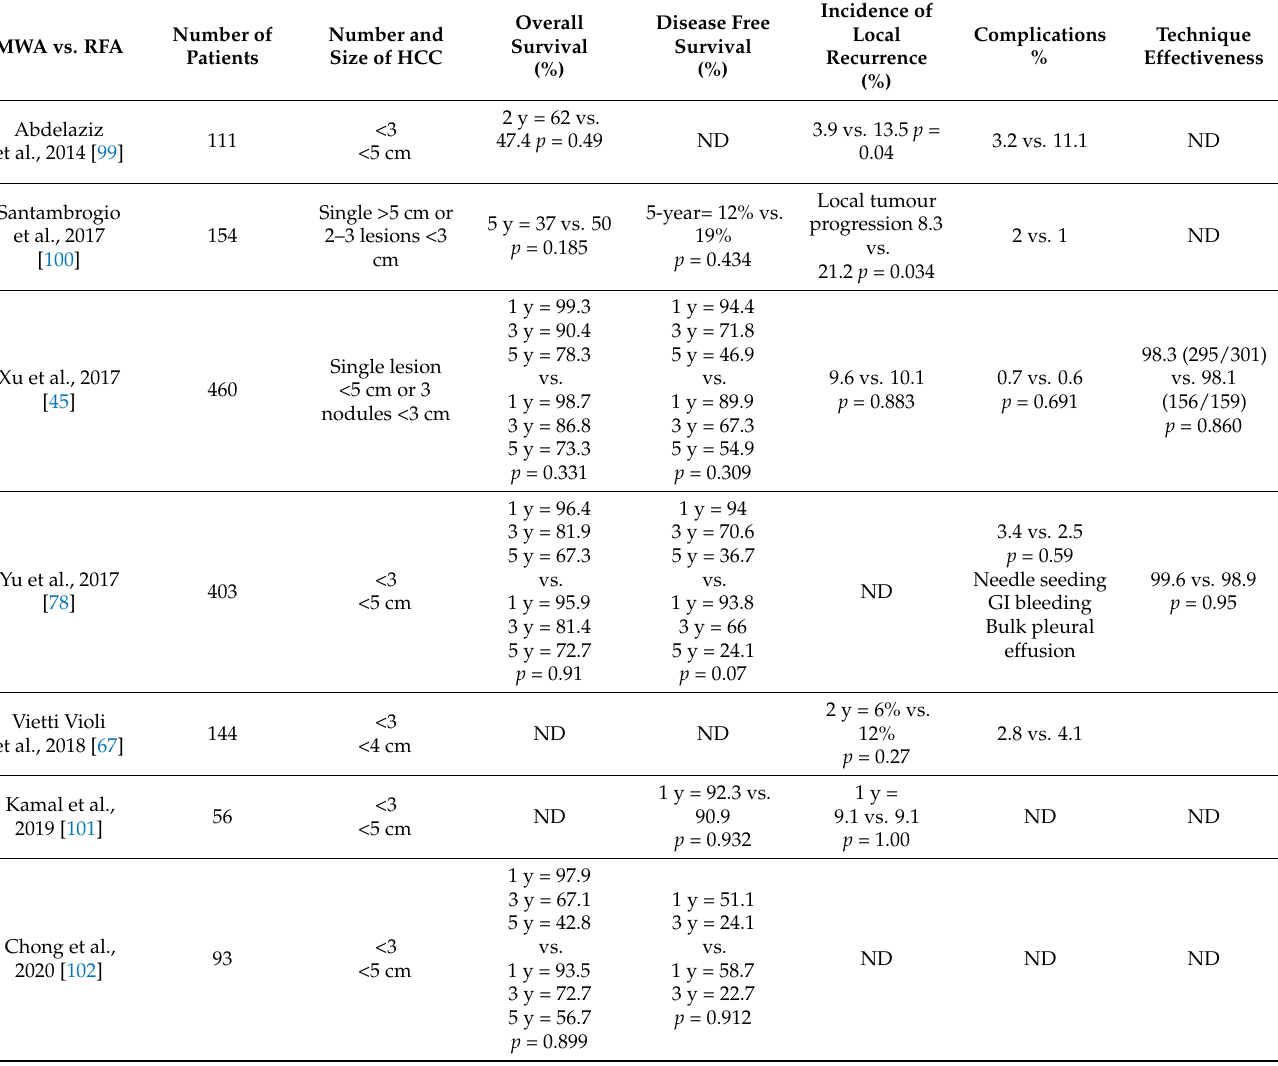
Table 2. Summary of recent studies comparing Microwave ablation (MWA) and